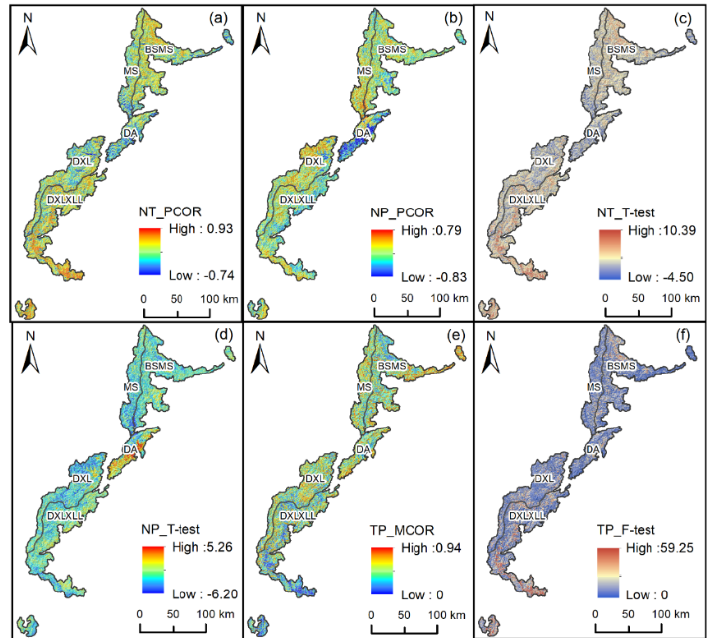
Figure 8. Partial correlation and complex correlation analysis results among NDVI, precipitation and temperature. ( a ) Partial correlation coefficient between temperature and NDVI; ( b ) partial correlation coefficient between precipitation and NDVI; ( c ) partial correlation t -test of temperature and NDVI; ( d ) partial correlation t -test of precipitation and NDVI; ( e ) multiple correlation coefficient between precipitation and temperature; ( f ) multiple correlation F-test of precipitation and temperature.